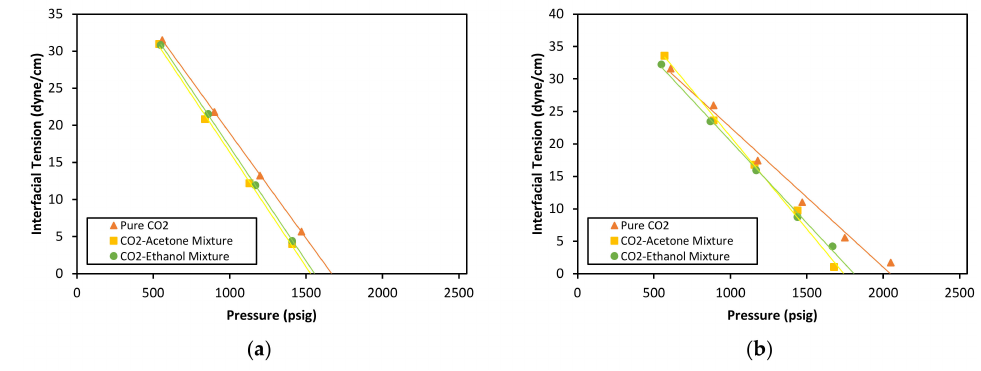
Figure 3. Interfacial tension (IFT) data results at ( a ) 131 ◦ F and ( b ) 158 ◦ F [12].